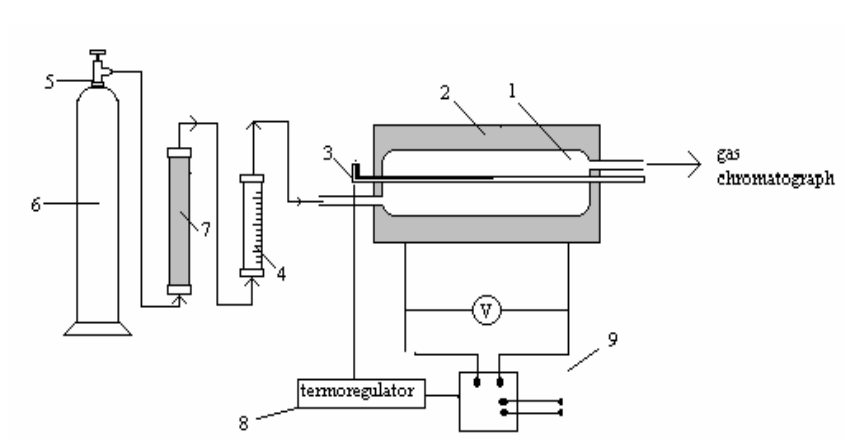
Fig. 1 Block diagram of the experimental installation under dynamic conditions: 1-quartz reaction; 2-electric oven; 3-thermocouple; 4-ammonia flow meter; 5-pressure reducer; 6- liquid ammonia cylinder (99.98% purity); 7- drying vessel with silica gel;8- temperature regulator; 9-